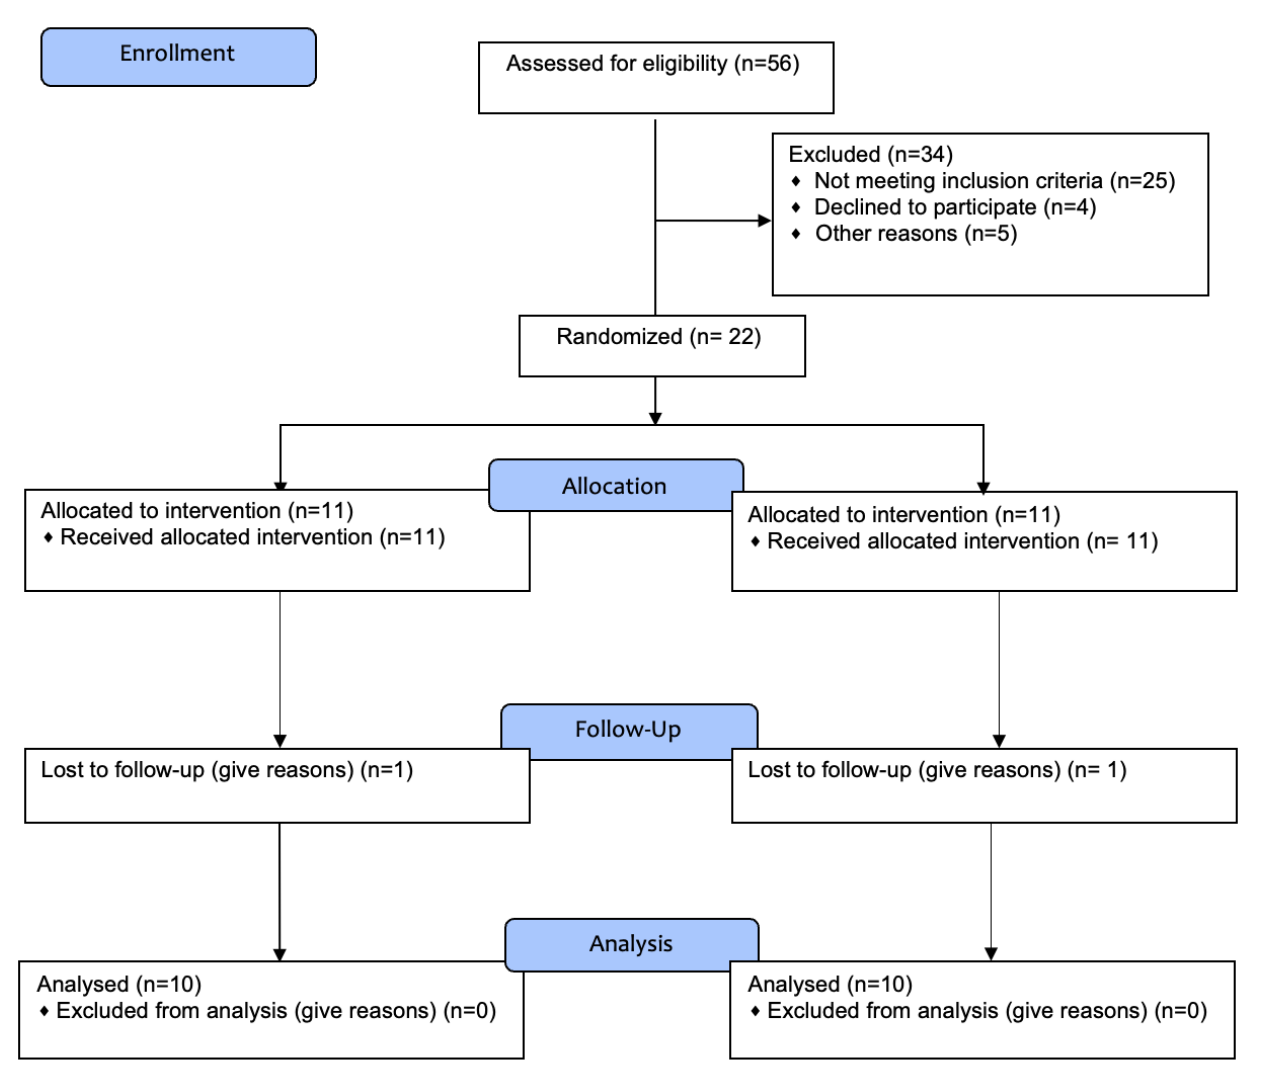
Figure 3. CONSORT flow